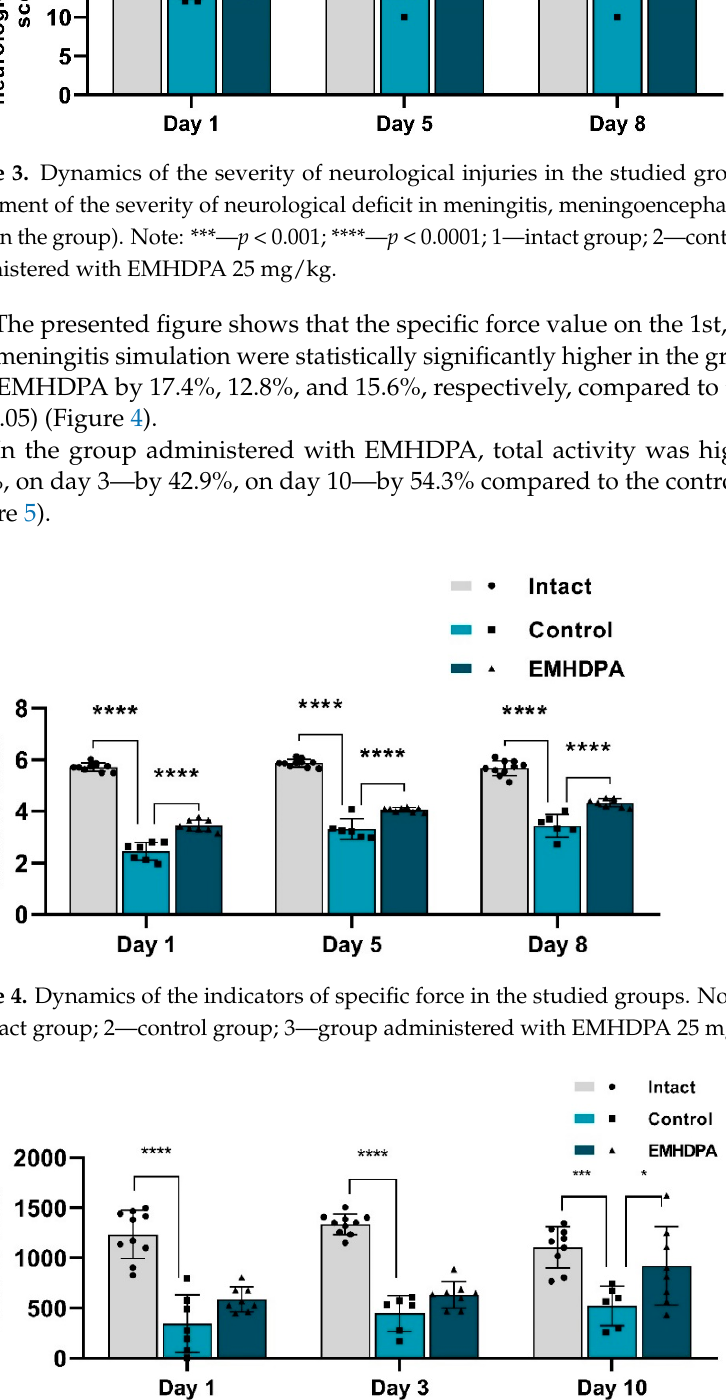
Figure 6. The effect of the studied drugs on the motor stereotypies in the actimetry test. Note: *— p < 0.05; **— p < 0.01; ****— p < 0.0001; 1—intact group; 2—control group; 3—group administered with EMHDPA 25 mg/kg. In the group administered with 2-ethyl-6-methyl-3-hydroxypyridinium 2,6-dichloro- phenyl(amino)phenylethanoate, the maximum speed was higher on day 1 by 104%, on day 3—by 42.6%, on day 10—by 41% compared to the control group ( p < 0.05) (Figure 7). Figure 7. The effect of the studied drugs on the maximum speed in the actimetry test. Note: *— p < 0.05; **— p < 0.01; ****— p < 0.0001; 1—intact group; 2—control group; 3—group administered with EMHDPA 25 mg/kg.